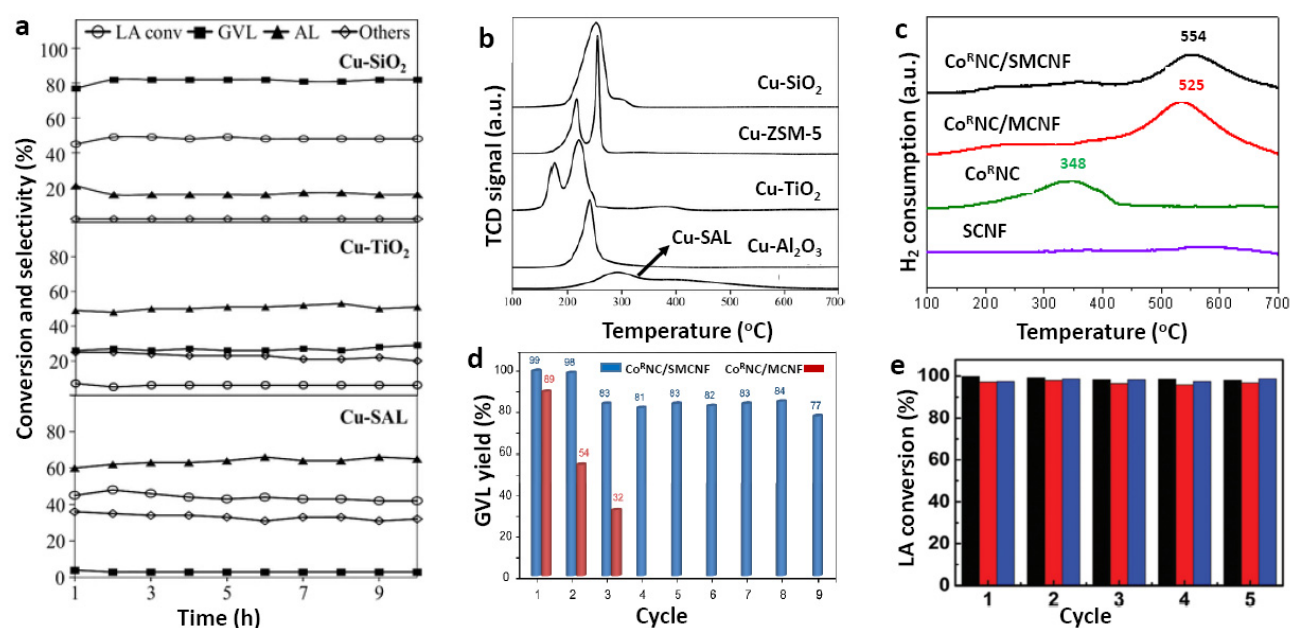
Figure 10. ( a ) Time ‐ on ‐ stream activity of catalysts. ( b ) H 2 ‐ TPR profiles of different supported copper catalysts. Reproduced with permission from Reference [55]. Copyright 2017, Springer. ( c ) H 2 ‐ TPR profiles of the SMCNF and Co ‐ based catalysts. ( d ) Comparative stability investigation of Co R NC/SMCNF and Co R NC/MCNF. Reproduced with permission from Reference [72]. Copyright 2014, Elsevier Ltd. ( e ) The reusability of Zr–CA at 130 ◦ C with a duration of 10 h. Reproduced with permission from Reference [68]. Copyright 2018, American Chemical